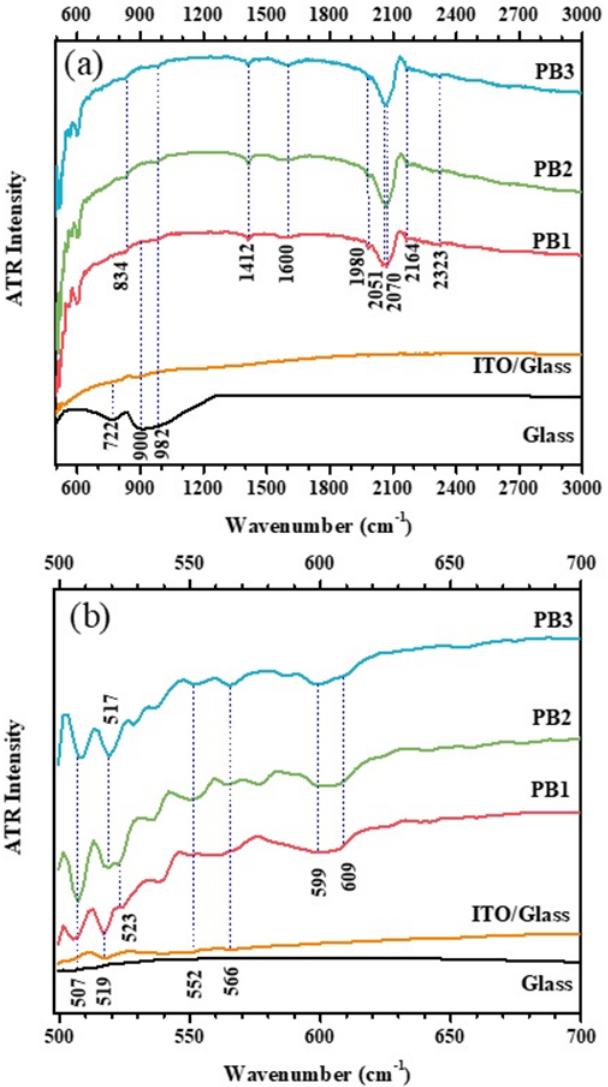
Figure 4. ( a ) FTIR-ATR spectra of the PB films prepared on top of ITO/Glass substrates, measured in the 500–3000 cm − 1 wavenumber region. In ( b ) is the zoomed spectra in the 500–700 cm − 1 region. The measured spectra of ITO/Glass and Glass substrates are also shown, for comparison.